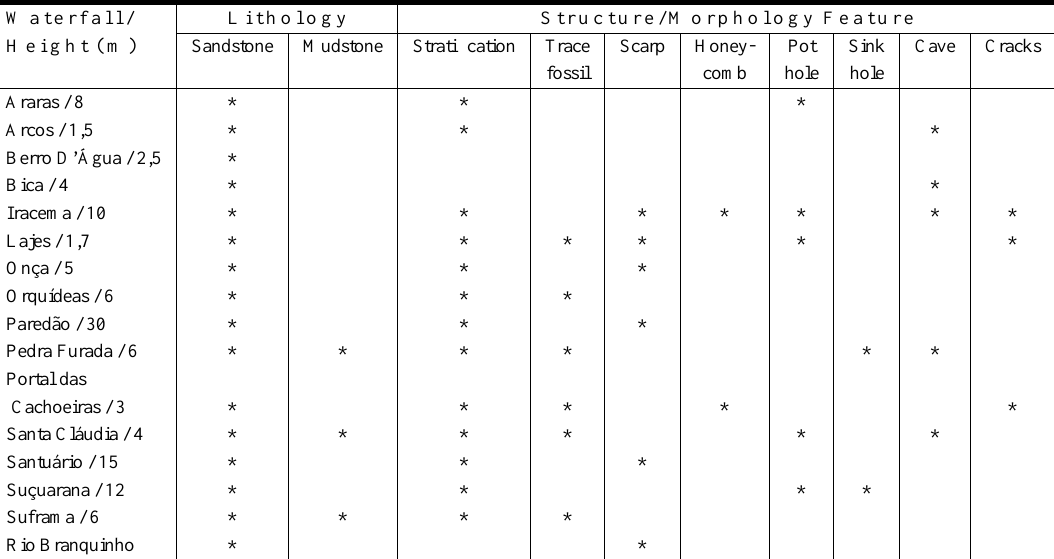
Main characteristics of the studied